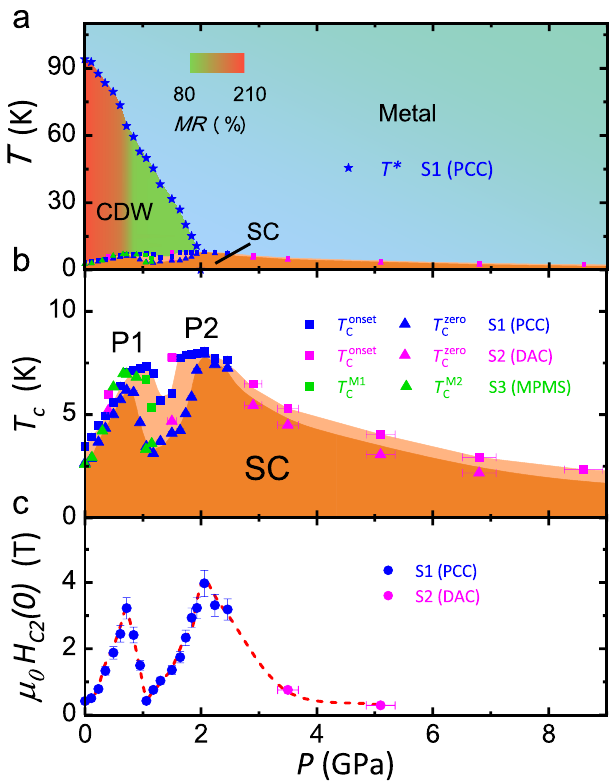
Fig. 3 Phase diagram with pressure for CsV 3 Sb 5 single crystal. a Phase diagram of CsV 3 Sb 5 with pressure. CDW transition temperature T * gradually suppressed with increasing the pressure. T * shows an anomaly around P1. The color inside the CDW phase represents the magnitude of magnetoresistance measured at 9 T and 10 K. b Pressure dependence of superconducting transition temperatures T onset c , T zero c , T M 1 c and T M 2 c measured on various samples. T c is strongly suppressed with the pressure between P1 and P2. c Pressure dependence of upper critical fi eld at zero temperature, two peaks can be observed at P1 and